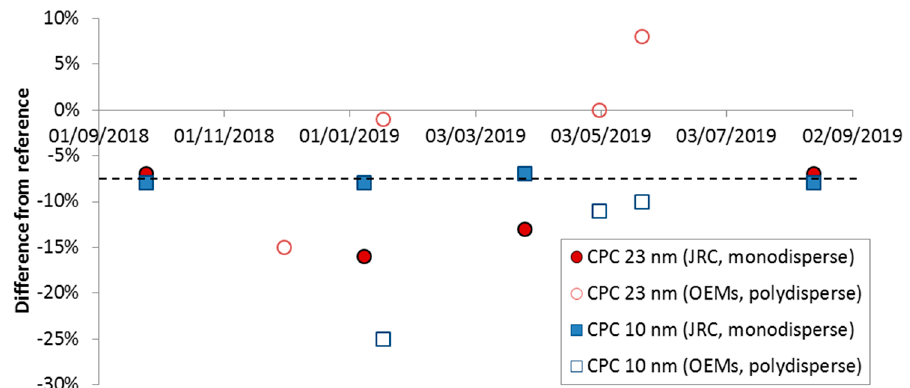
Figure A1. Comparisons of “Golden” CPCs with reference instruments at JRC using monodisperse graphite particles or with the PMP systems at OEMs using polydisperse engine soot. CPC = Condensation particle counter; OEM = Original equipment manufacturer; JRC = Joint Research Centre.